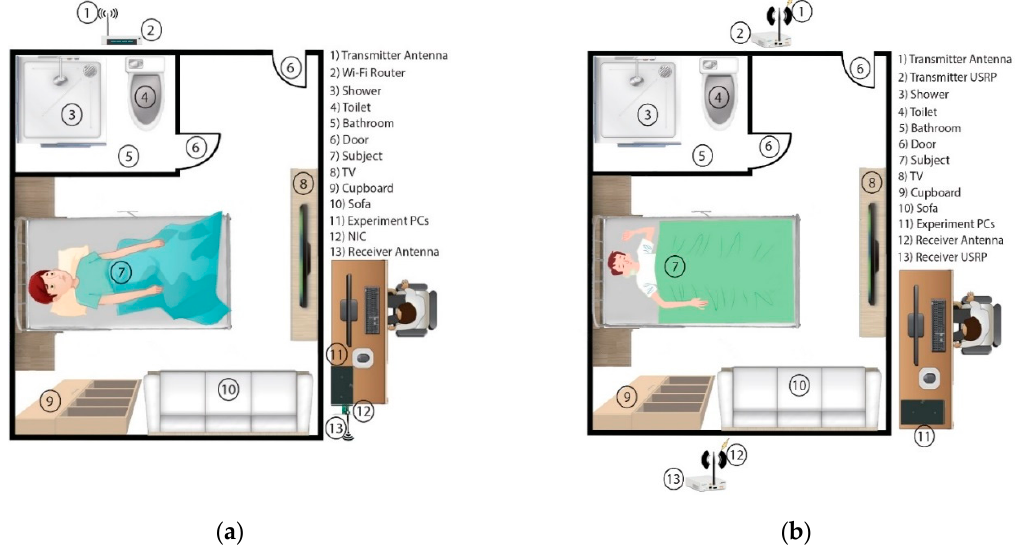
Figure 4. Proposed experimental setup: ( a ) commercial hardware platform; ( b ) specialize hardware platform.